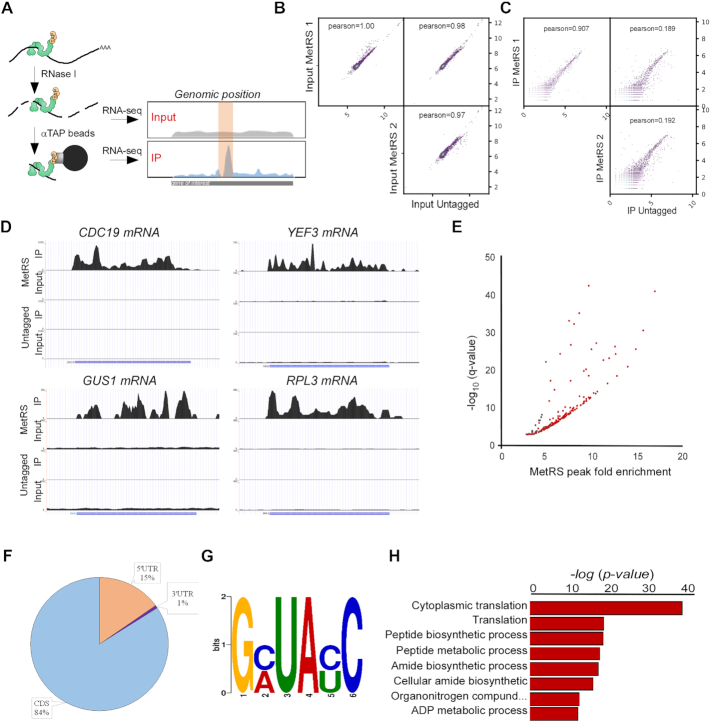
fRIP-seq protocol to identify RBP’s binding regions. (A) Scheme of the fRIP-seq protocol. Cell lysates of TAP-tagged MetRS strain are subjected to mild RNase I treatment. Fragmented lysate was mixed with IgG Sepharose beads to isolate the MetRS-TAP-bound RNA. Input and immunoprecipitated (IP) fragments were subjected to RNA-seq. Peak calling algorithm (40) is used to define regions that are enriched in the IP compared to the Untagged control fragments. (B) fRIP-seq Input RNA samples from two biologically independent MetRS-TAP cultures and from untagged parental strain were subjected to RNA-seq. Scatter plots present the pairwise comparisons of sequencing reads. Pearson correlation coefficient is shown in each box. (C) fRIP-seq for IP samples, collected and analyzed as in B. (D) Examples of fRIP-seq read maps of IP and Input data from MetRS-TAP and untagged strains. Y axis to the left of every map indicates the number of reads (note that scales differ between genes). Schematic depiction of the gene is indicated below each map. (E) Assignment of significant peaks. Scatter plot indicates the fold-enrichment (compared to Untagged control) for each peak defined by MACS2 callpeak algorithm (40) vs. the significance (as log10 of the q-value). Red-marked dots indicate peaks that are defined as significant (Irreproducible Discovery Rate (IDR) < 0.05). (F) Pie chart indicates the position of significant peaks along detected genes. (G) MetRS-bound peaks were analyzed for an enriched sequence motif by DREME (59). (H) MetRS-bound peaks were analyzed for enriched process terms by SGD GO Term Finder Version 0.86. The most significant terms (corrected P-value <9.49E–13) are presented.